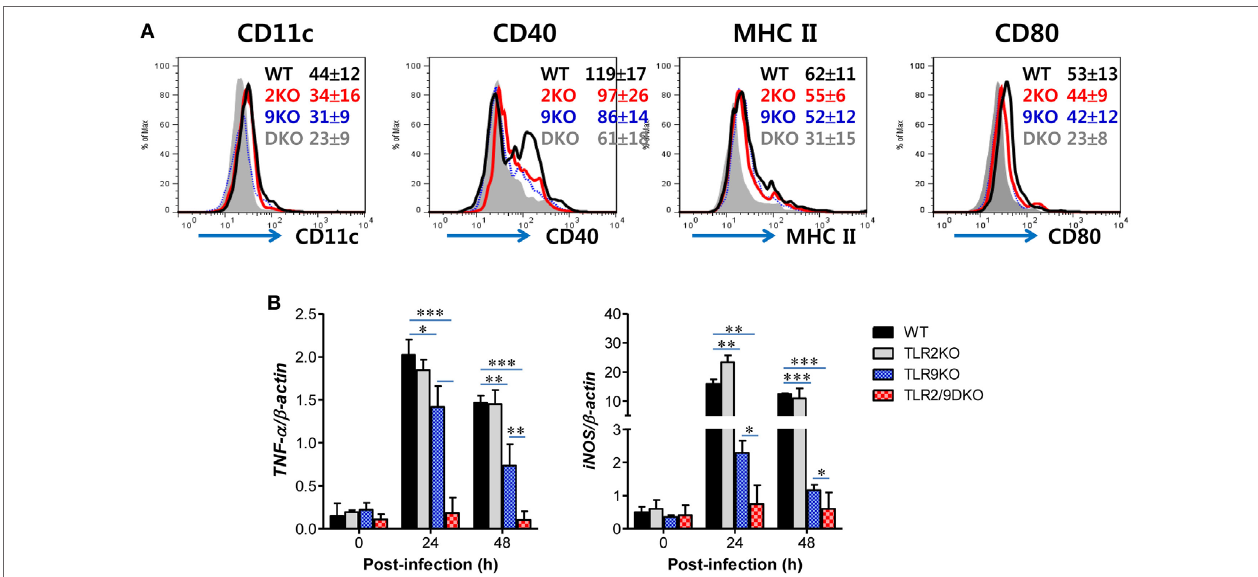
FigUre 8 | Direct recognition of both TLR2 and TLR9 to promote Ly-6C hi monocyte differentiation into TNF- α and iNOS-producing dendritic cells. (a) Phenotypic changes of sorted Ly-6C hi monocytes after herpes simplex virus (HSV)-1 infection. Ly-6C hi monocytes sorted from the spleen of wild-type (WT), TLR2 KO, TLR9 KO, and TLR2/9 double knock-out (TLR2/9 DKO) mice were infected with HSV-1 (5.0 moi) and used for surface staining with the indicated markers 24 h later. The values in the histograms denote the average ± SEM of MFI for the indicated surface marker after gating on CD11b + Ly-6C hi monocytes. (B) TNF- α and iNOS expression in HSV-1-infected Ly-6C hi monocytes. The levels of TNF- α and iNOS mRNA were determined by real-time qRT-PCR using the total RNA extracted from sorted Ly-6C hi monocytes 24 h after HSV-1 infection. Data in the bar graphs denote the average ± SEM of values derived from at least three independent experiments ( n = 4–5). Two-way ANOVA followed by Bonferroni post hoc testing was conducted in (B) . * p < 0.05; ** p < 0.01; *** p < 0.001 comparing levels between the indicated